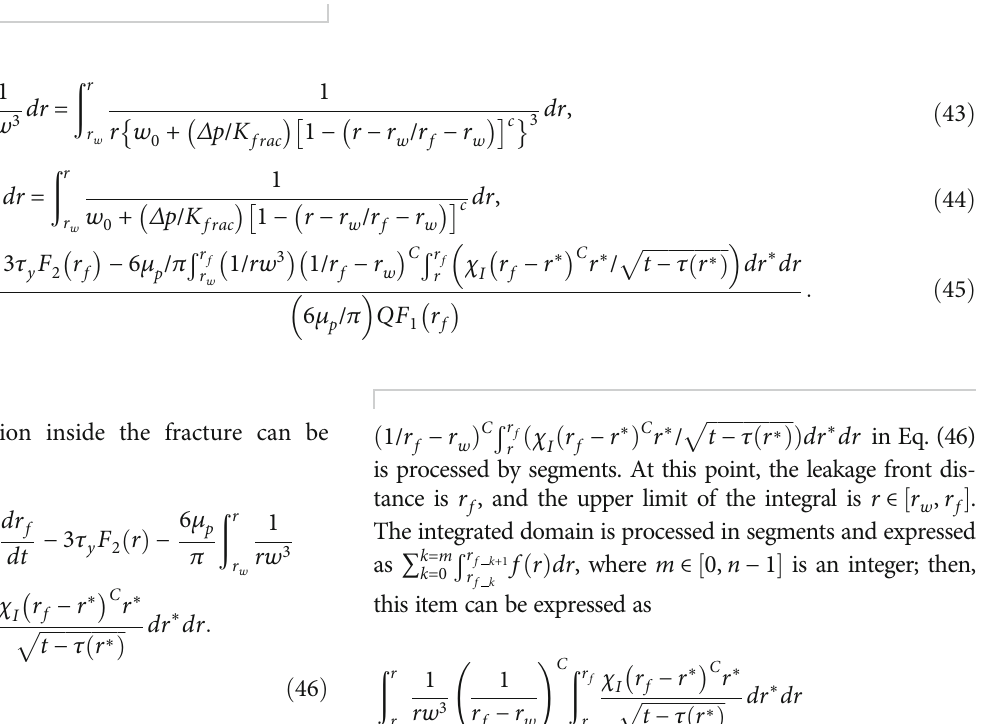
(cid:3) C r ∗ ffiffiffiffiffiffiffiffiffiffiffiffiffiffiffiffiffi p dr ∗ dr : t − τ r ∗ ð Þ ð 47 Þ